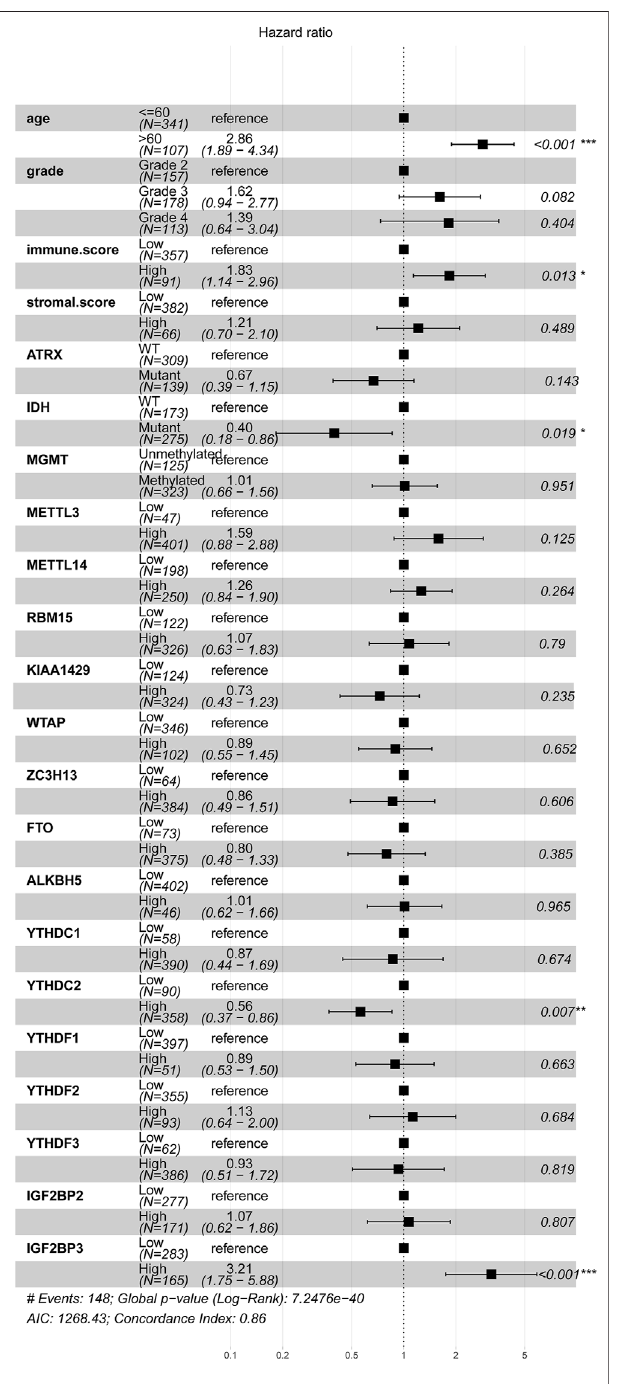
FIGURE3| Associationbetweenm 6 Aregulatorandprognosisofglioma samples.TheforestplotshowedtheresultofmultivariateCoxregressionanalysisfor the association between m 6 A regulator ’ s expression, clinical features, and Kaplan – Meier estimated overall survival probability of glioma samples. Values within brackets represent the 95% con fi dence interval of the hazard ratio.